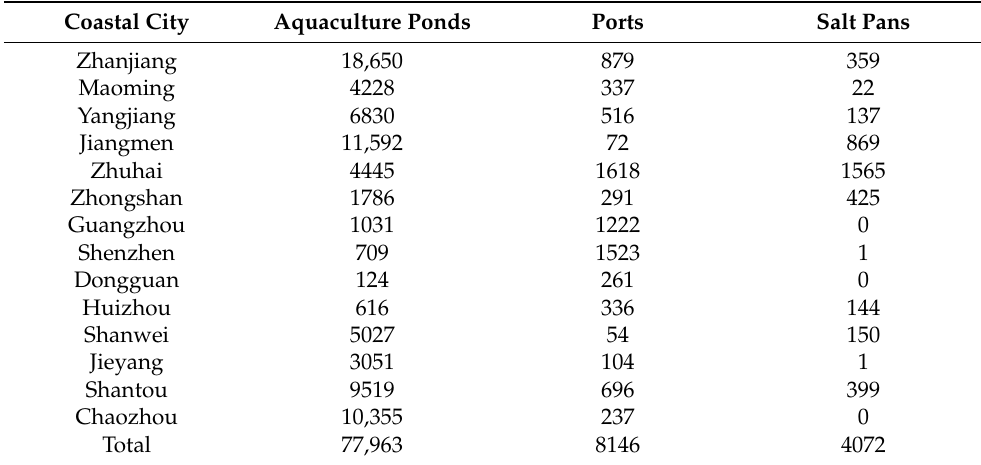
Table 10. Three types of reclamation in Guangdong Province (Unit: ha). Coastal City Aquaculture